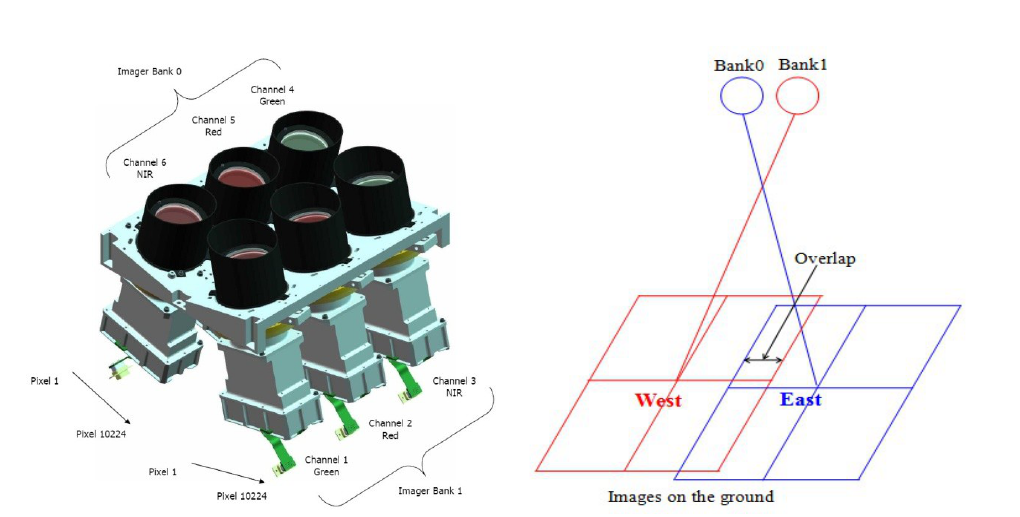
Figure 1. Channel layout of the Beijing-1/MS ( Left ) and the relationship between the cameras and images of the Beijing-1/MS ( Right